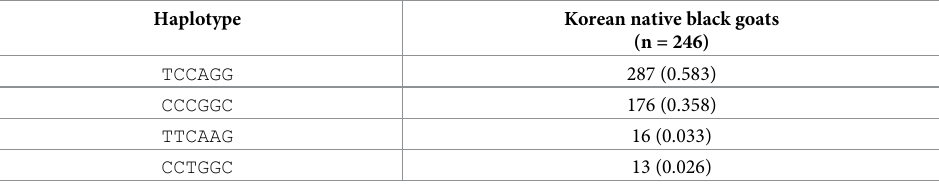
Table 3. Haplotype frequencies of the six PRND polymorphisms in Korean native black